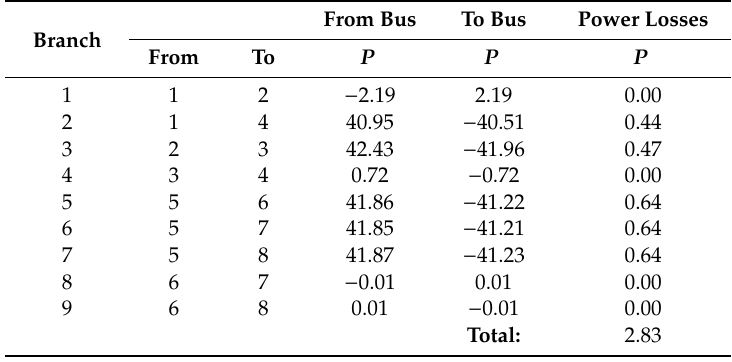
Table A38. Results of the mixed AC / DC PF calculations in Case 7-2. DC branch data.